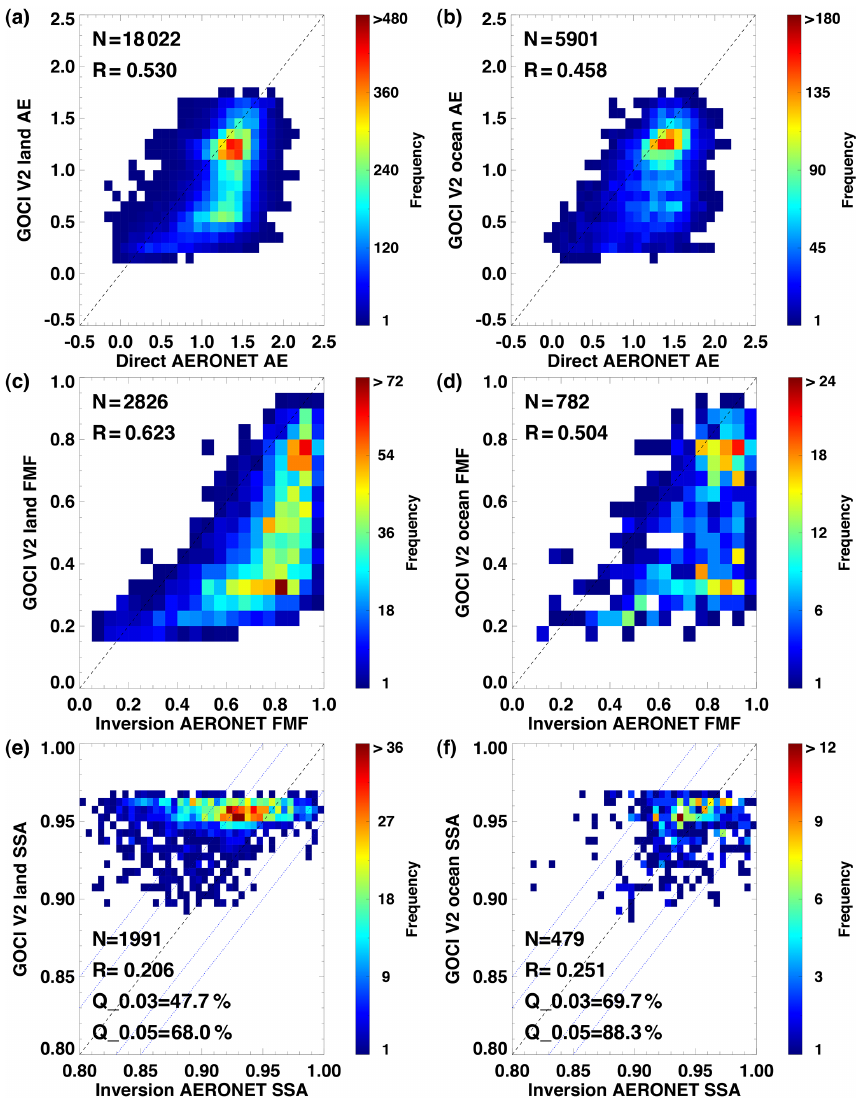
Figure 5. Comparison between AERONET and GOCI YAER V2 (a) land AE, (b) ocean AE, (c) land FMF, (d) ocean FMF, (e) land SSA, and (f) ocean SSA. Note that collocated data are only for AERONET AOD>0.3 for the AE and FMF comparisons, and AERONET AOD>0.4 for the SSA comparison. Each colored pixel represents a bin size of 0.10 for AE, 0.05 for FMF, and 0.005 for SSA. Black dashed lines denote the one-to-one line, and blue dotted lines in the SSA comparison denote the ± 0.03 and ± 0.05